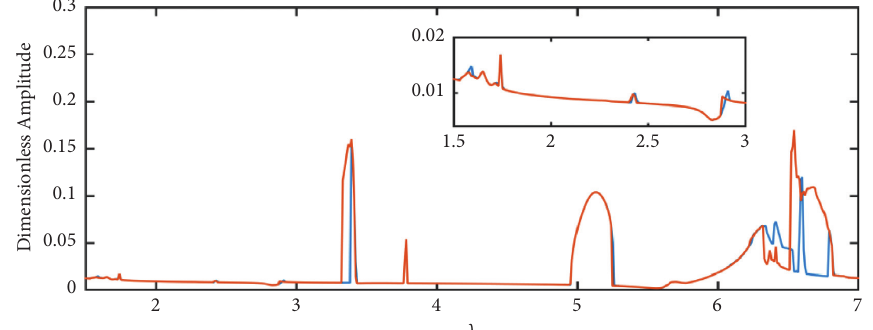
Figure 11: The amplitude-frequency curves of responses of disc in horizontal direction when N brown line means run-down